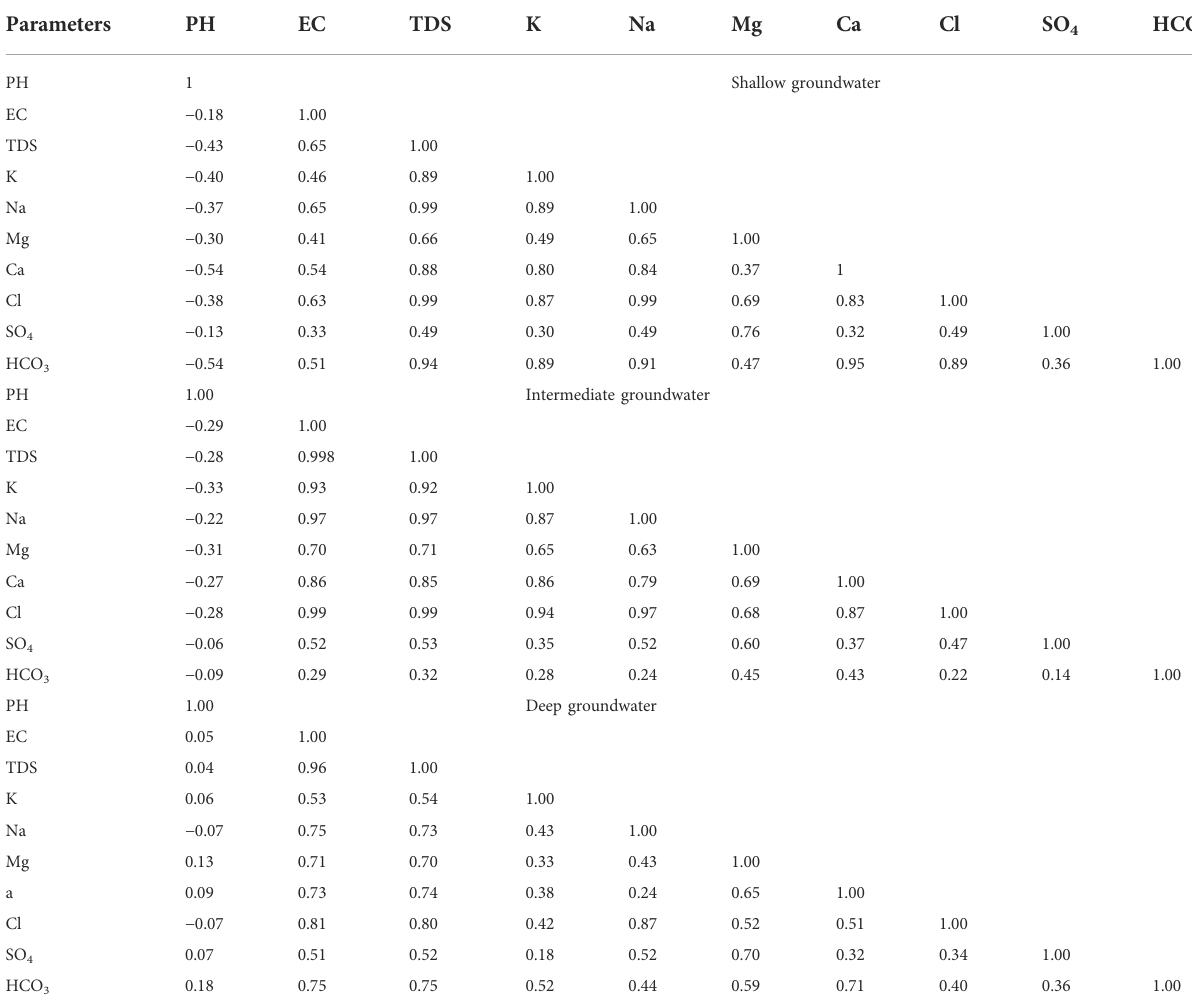
TABLE 4 Correlation matrix between physicochemical parameters in shallow, intermediate, and deep groundwater.